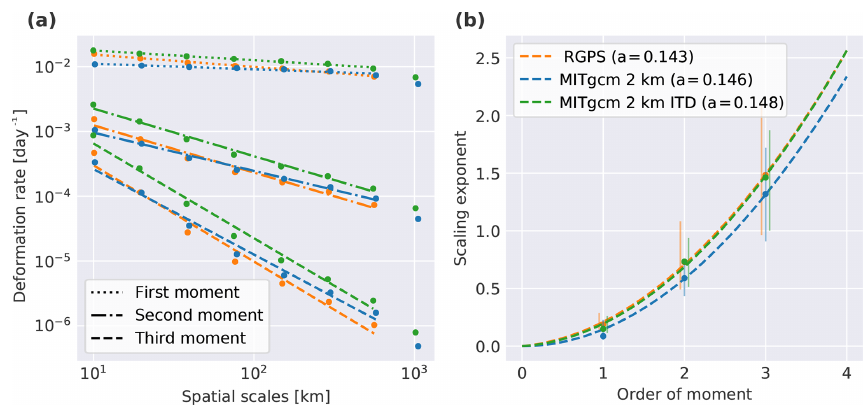
Figure 1. (a) The first three moments of sea ice deformation rate as a function of the spatial scale for RGPS and both model simulations. (b) The spatial scaling exponents as a function of the moment order. A quadratic structure function β (q) = aq 2 + bq is fitted (dashed lines). The curvature of the fit is given in the legend. The error bounds of the scaling exponents are determined by the minimum and maximum slope between successive points of the power law fit.